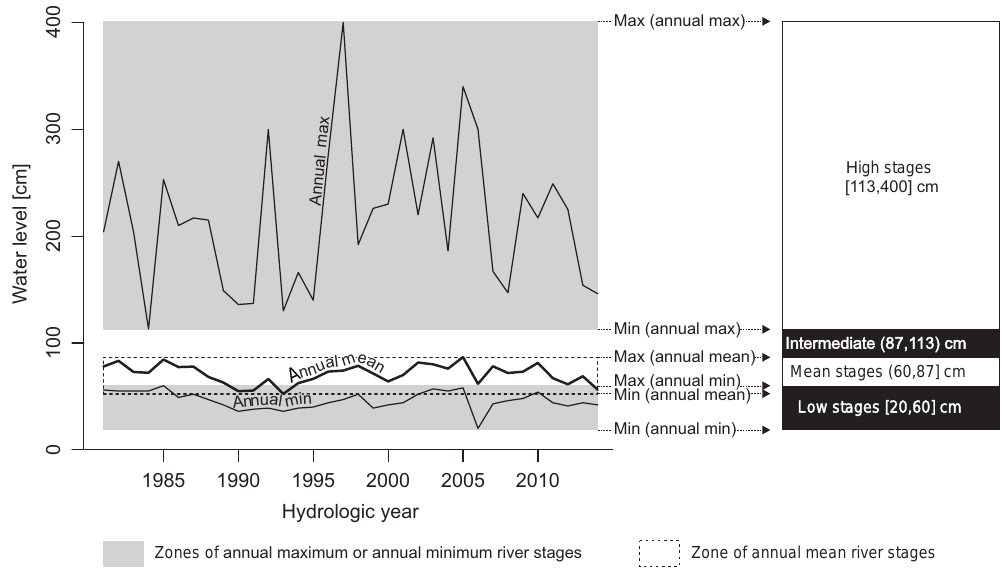
Figure 7. Time series of annual minimum, annual mean, annual maximum river stage computed for Gorzuchów in hydrologic years 1982– 2014 (note that in Poland a hydrologic year begins on 1 November) along with their main statistics and the resulting characteristic river stage